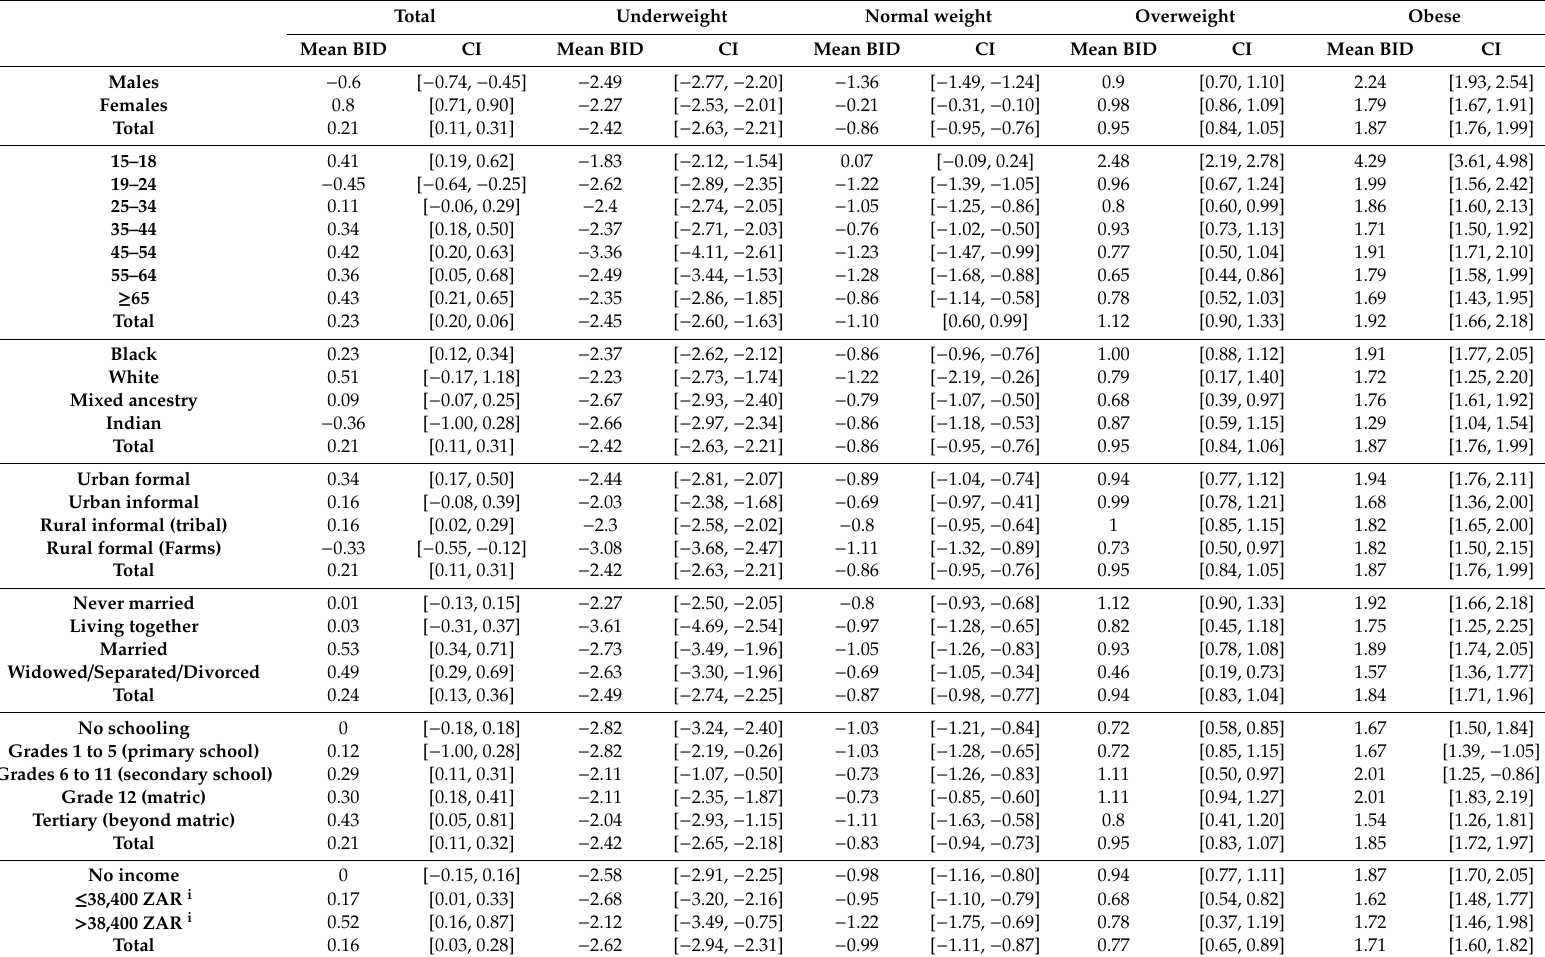
Table 2. Mean body image discrepancy (BID) scores of adult South Africans aged 15 years and older, SANHANES 2012 1